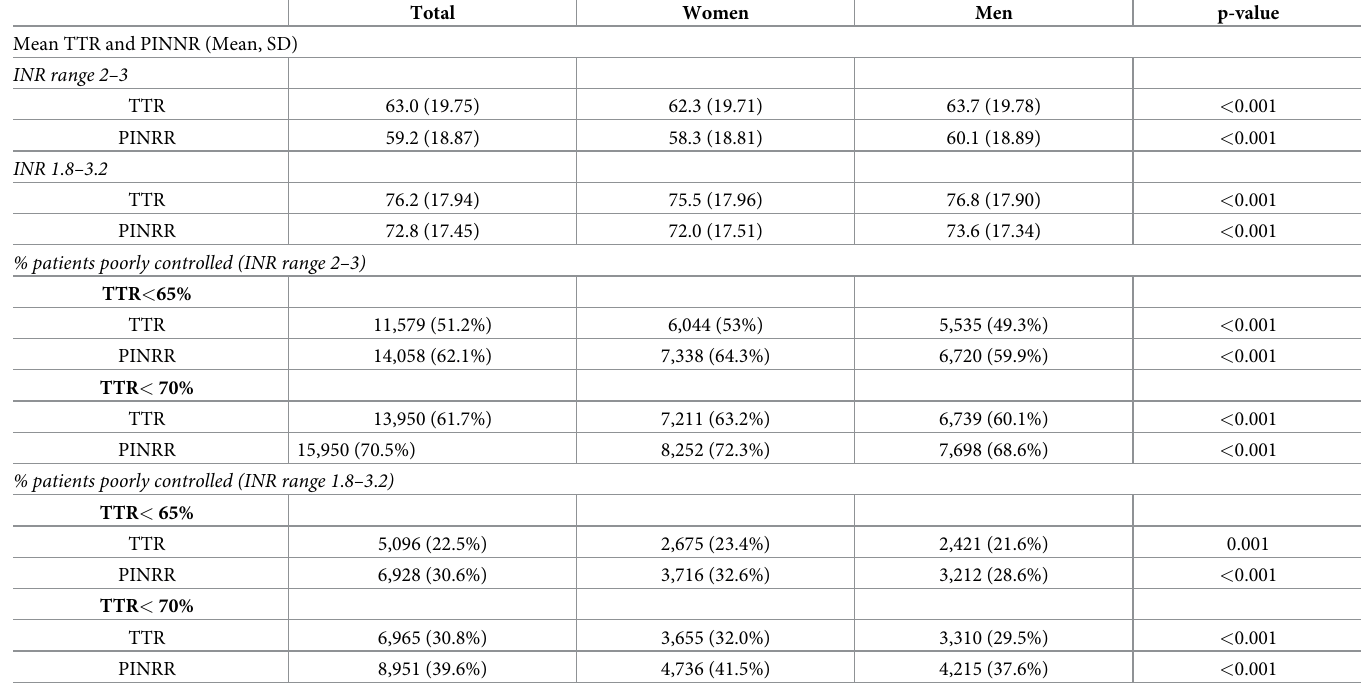
Table 2. Mean TTR, PINRR and % of patients poorly controlled considering NICE (TTR � 65%) and ESC (TTR � 70%) thresholds and different acceptable INR range